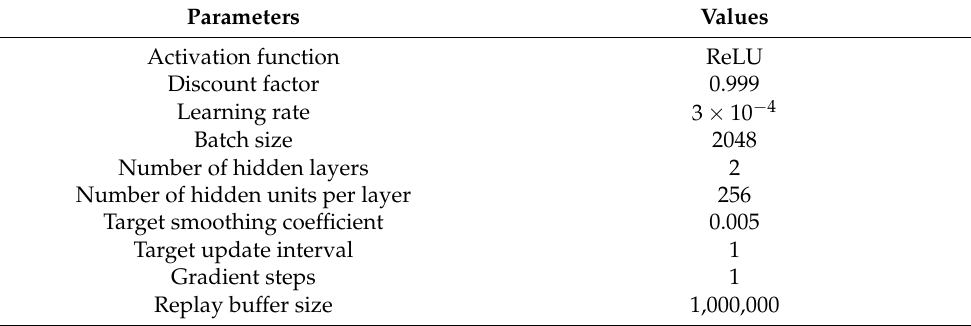
Table 8. SAC agent